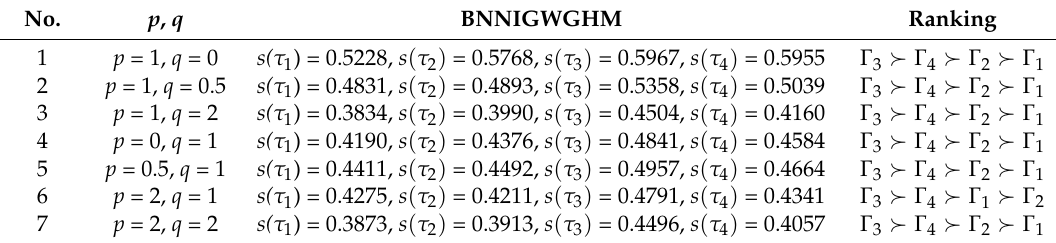
Table 3. The ranking with different p and q based on BNN improved generalized weighted geometry HM (BNNIGWGHM)